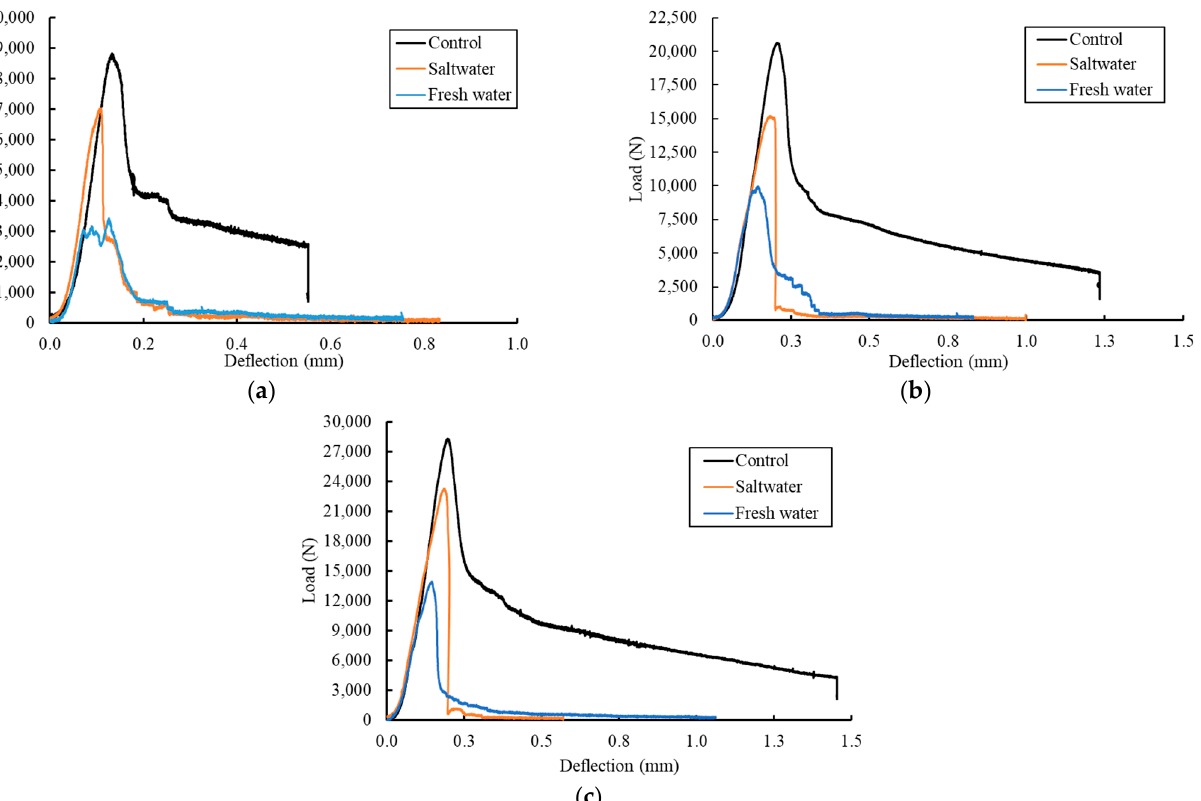
Figure 7. Load versus deflection curves after 60 days of exposure. ( a ) CFRP strip width of 25 mm (1.0 in.). ( b ) CFRP strip width of 50 mm (2.0 in.). ( c ) CFRP strip width of 75 mm (3.0 in.).